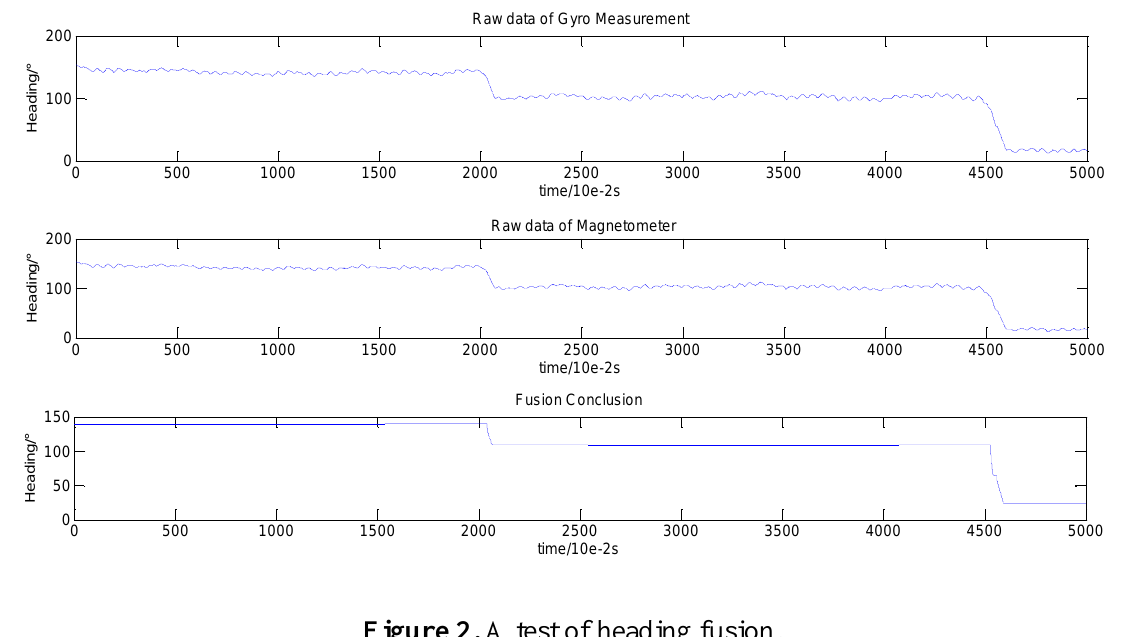
Figure 2. A test of heading